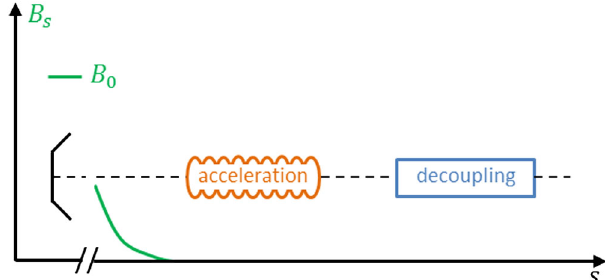
FIG. 6. Schematic sketch of the beam line of the experiment performed at NICCAD at FERMILAB [11].